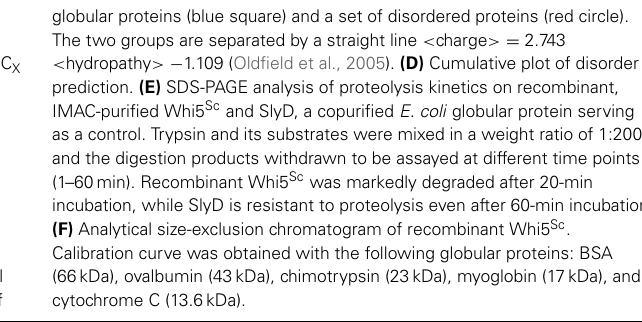
FIGURE 1 | Continued proteins (light blue bars) relative to a reference set of ordered, globular proteins. The fractional difference is calculated as (C X -C order )/C order , where C X is the content in a given amino acid of Whi5 Sc (or of the set of intrinsically disordered proteins) and C order is the corresponding value in the set of ordered proteins. Negative fractional difference indicates depletion, while positive difference indicates enrichment, in the corresponding amino acid. Amino acids are arranged on the x axis from the most rigid to the most flexible according to the Vihinen’s flexibility scale (Vihinen, 1987). The error bars correspond to the confidence intervals evaluated by the 10,000 bootstrap iterations in the definition of the reference protein sets. (C) Charge-hydropathy plot of Whi5 Sc (green diamond). The plot is an empirical graph representing data of net charge and mean hydrophobicity for a set of